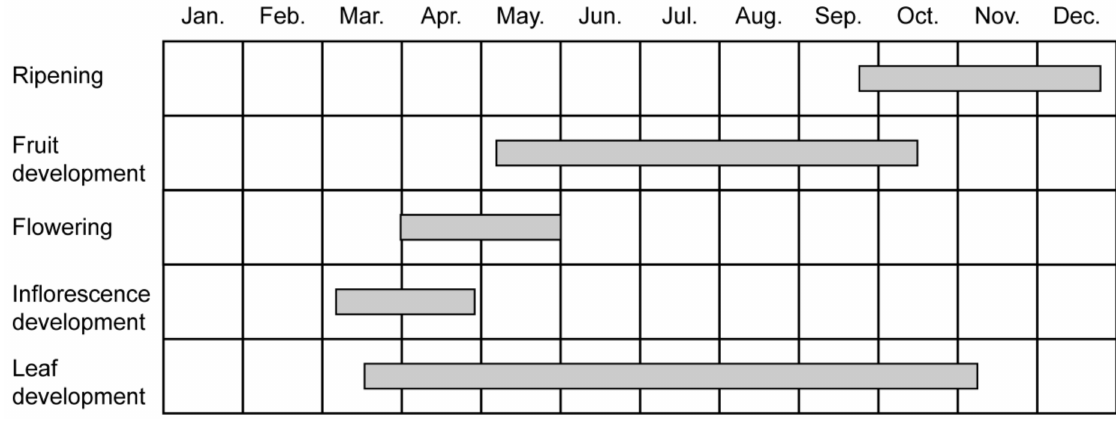
Figure 1. Development of olive trees during the growing